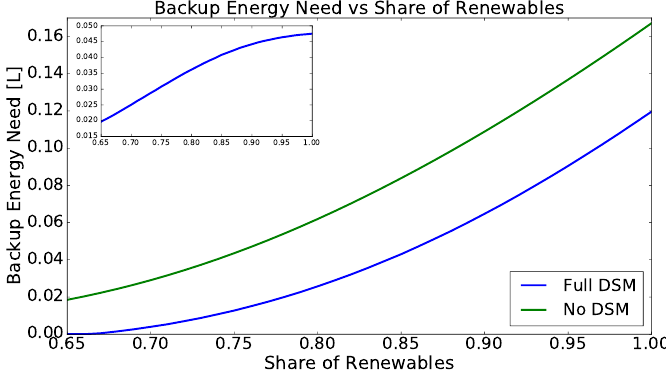
Figure 7. Need for backup energy in dependency of the renewable share in a European power system. Transmission capacities are assumed to be unlimited. The enclosed figure shows the difference between the two curves. The backup energy need is measured in units of the overall